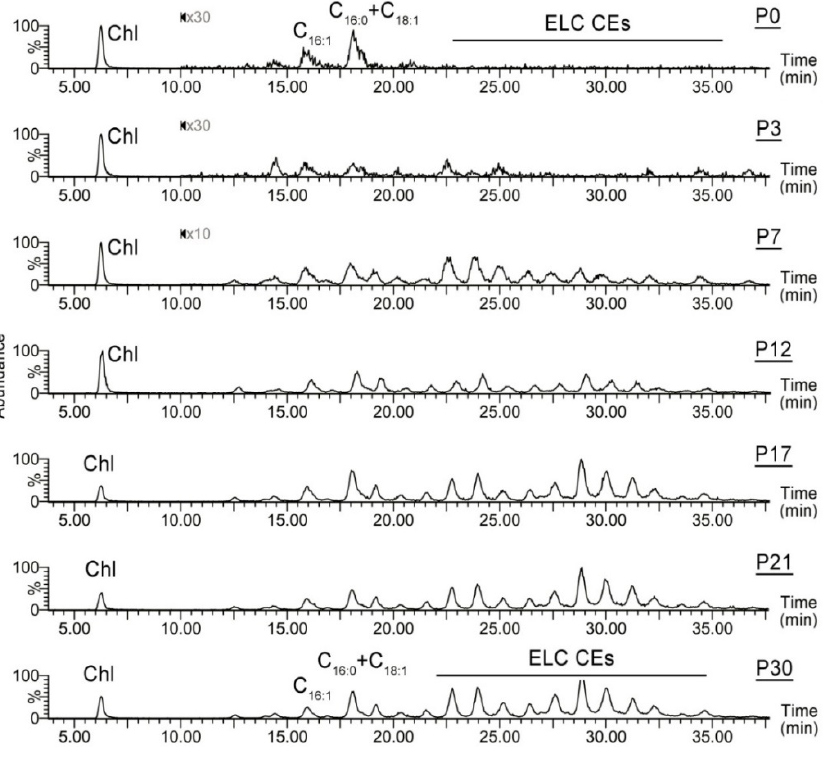
Figure 5. Age-dependent changes in the cholesteryl ester (CE) profiles of mouse Meibomian lipids. The esters were detected using their common analytical fragment with m / z 369.3539 (see Figure 1). Note the dominance of free cholesterol (Chl) and shorter-chain C 16 and C 18 -CEs in the P0 samples, and the gradual accumulation of extremely long-chain CEs in the samples obtained from maturing mice. Portions of chromatograms P0, P3, and P7 past 10 min are magnified 10 to 30 times for clarity.